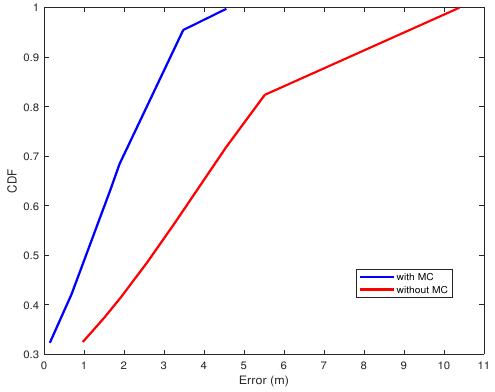
Figure 8. CDFs for real